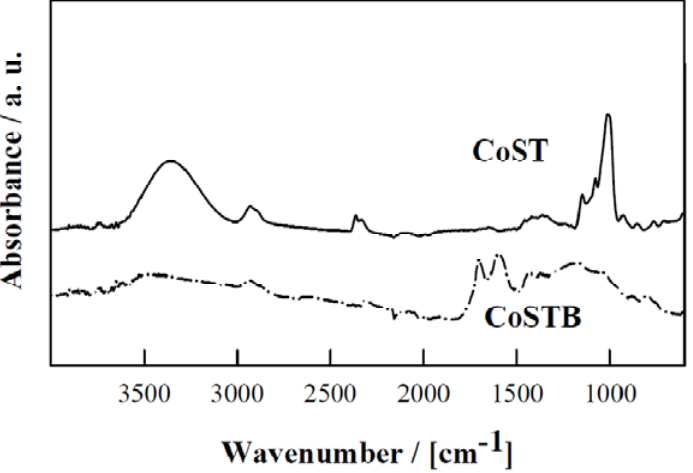
Figure 7. DRIFTs comparison between CuST and Cu-STB. Significant differences in functional groups were observed for both